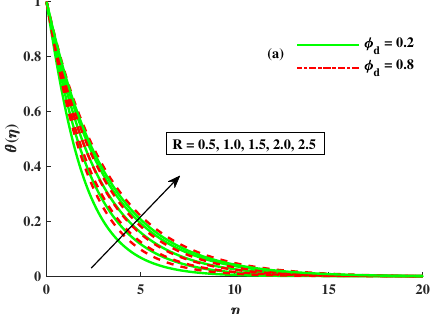
Figure 8. Fluctuation of R and φ d on θ and θ p .